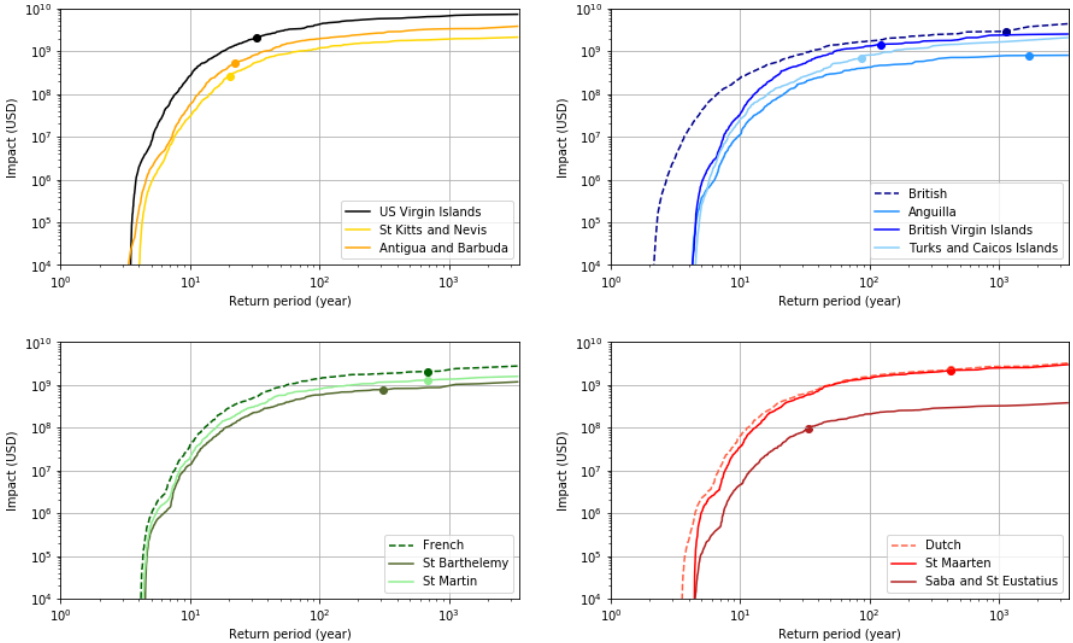
Figure 6. Impact exceedance frequency curves for the different island groups and their accumulated value per mainland power. The dots represent the damage reached by hurricane